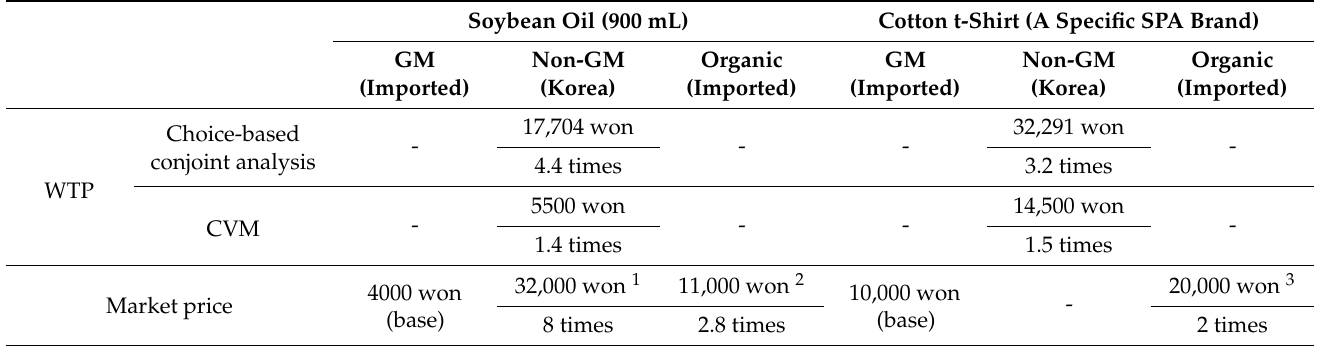
Table 9. Comparing WTP with the actual market price for a domestic non-GM product. Soybean Oil (900